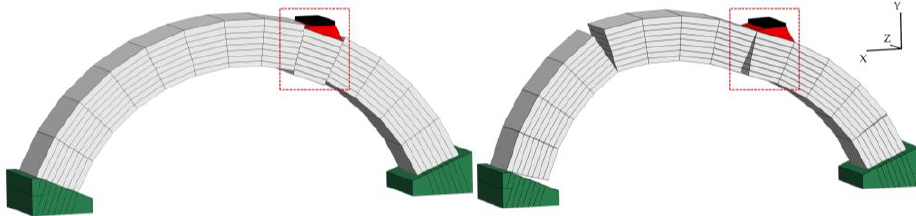
Figure 10. Pure sliding ( left ) and hinging ( right ) collapse mechanisms obtained using 27 and 35 degrees of friction angle at the joints, respectively.